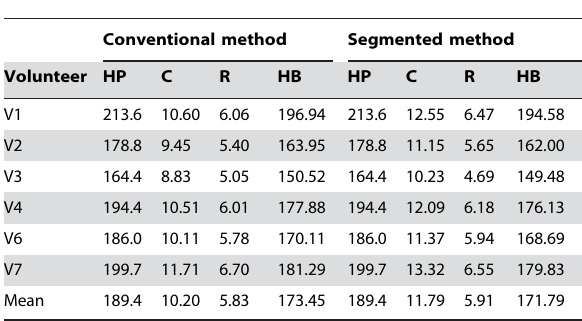
Table 9. Estimates of heat production, convective heat loss, radiant heat loss and heat balance using the conventional method and the segmented method when Ta is 35 u